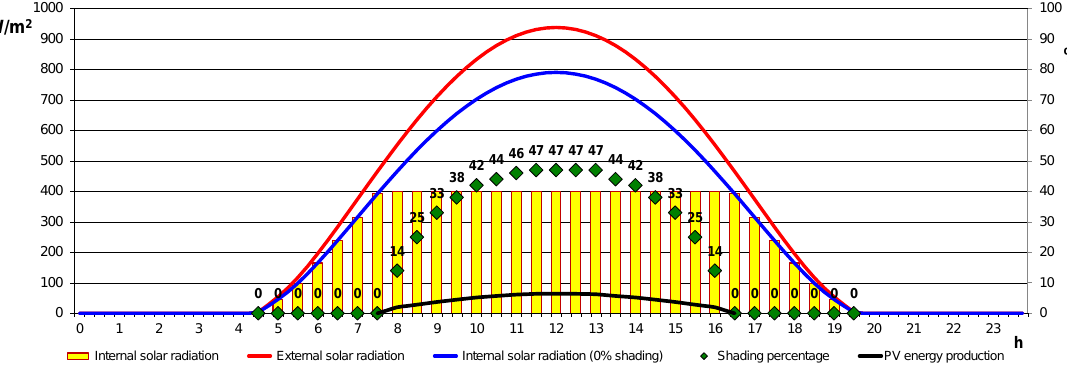
Figure 10. Daily trend of shading percentages so that the internal solar radiation is kept lower than or equal to the set limit on June 21.